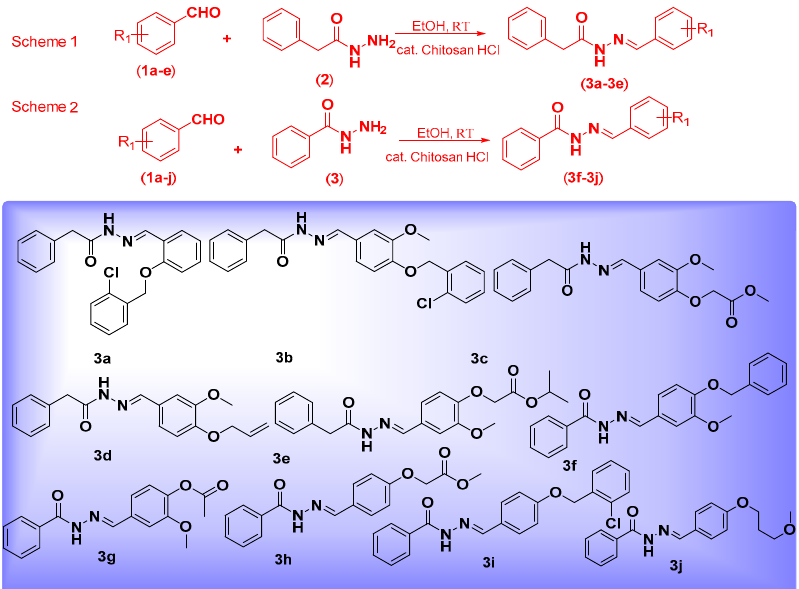
Figure 2. Schematic representation of employed synthesis schemes and studied hydrazide deriva- tives ( 3a – 3j ).